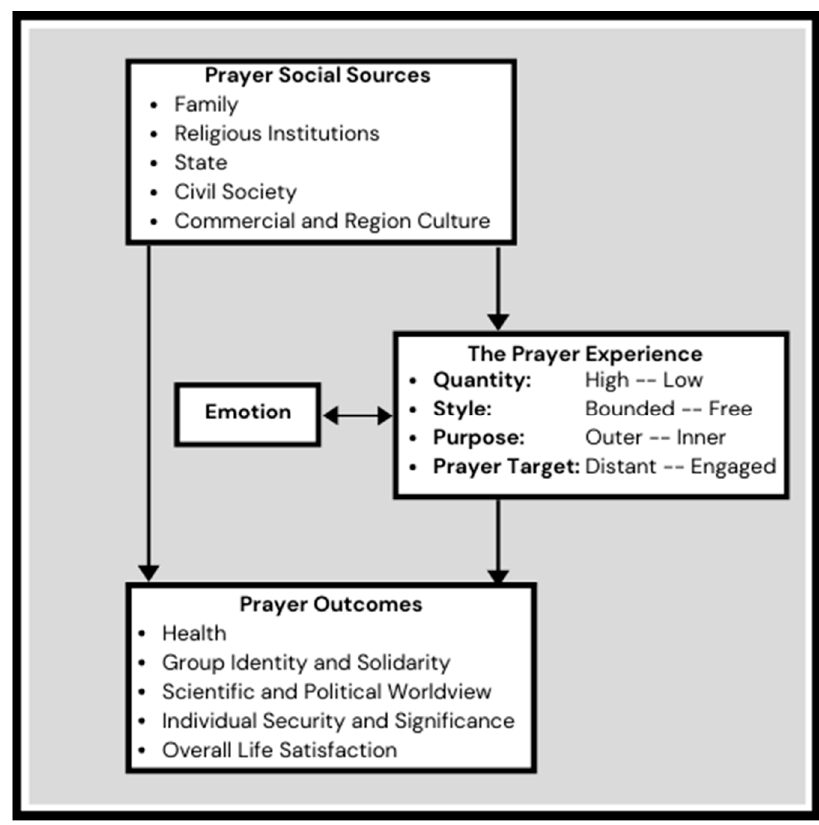
Figure 1. Sociology of Prayer: The Prayer